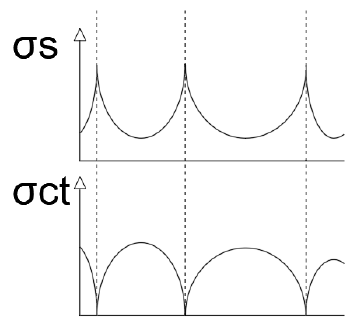
Figure 9. Variation in the tensions in concrete ( σ ct ) and steel ( σ s ) between cracks. In CALAVERA, J. (2008), Proyecto y cálculo de estructuras de hormigón. Tomo II, p. 372. (Designing and calculating concrete Structures, Volume II, p. 372). Give as [28].